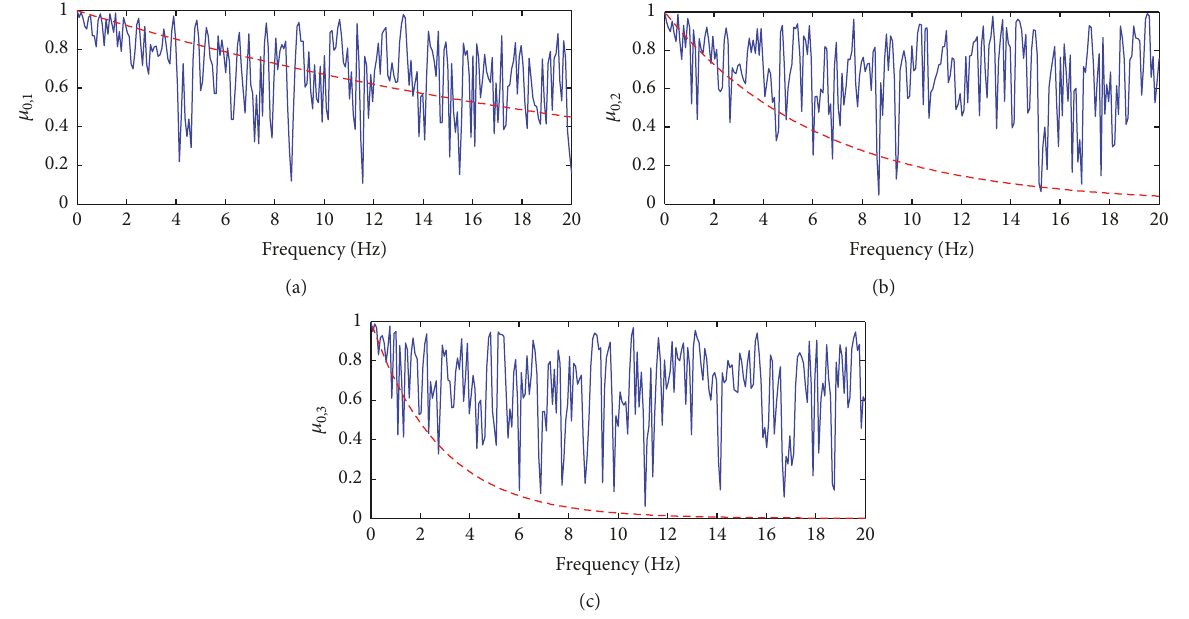
Figure 8: Comparison of coherency loss between the simulated accelerations with target